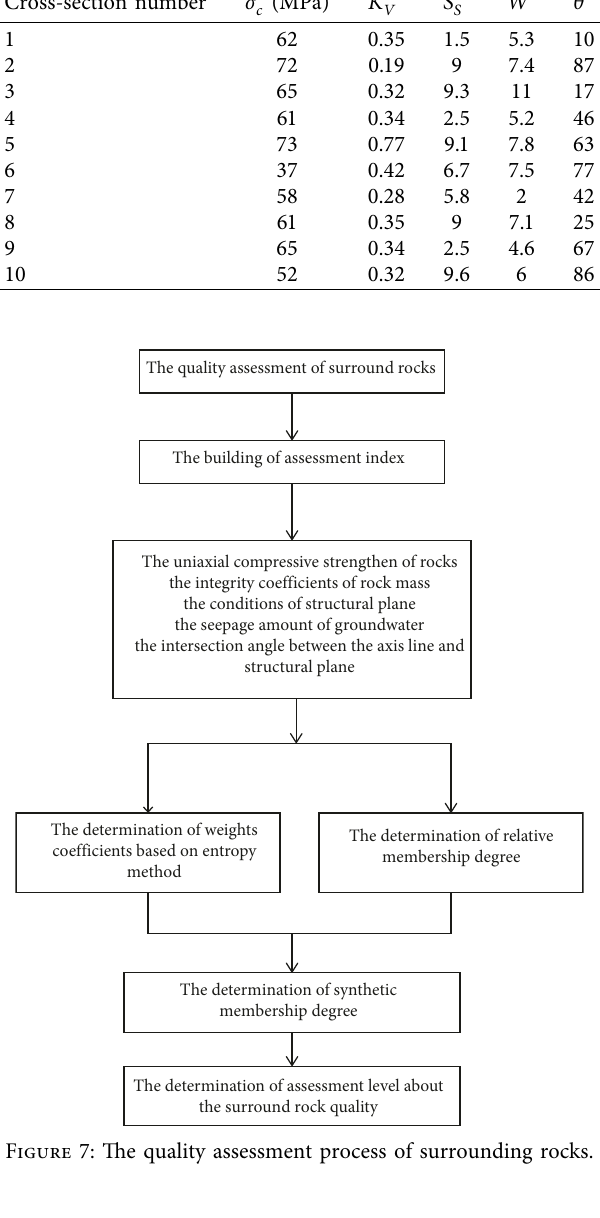
Figure 7: The quality assessment process of surrounding